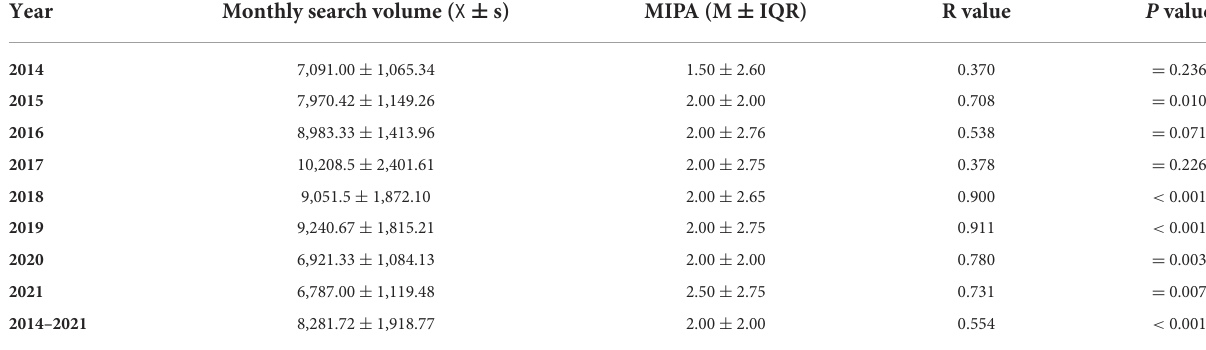
TABLE 1 Correlation between the monthly search volume of “Allergic Rhinitis” and “the meteorological index of pollen allergy” in Wuhan from 2014 to